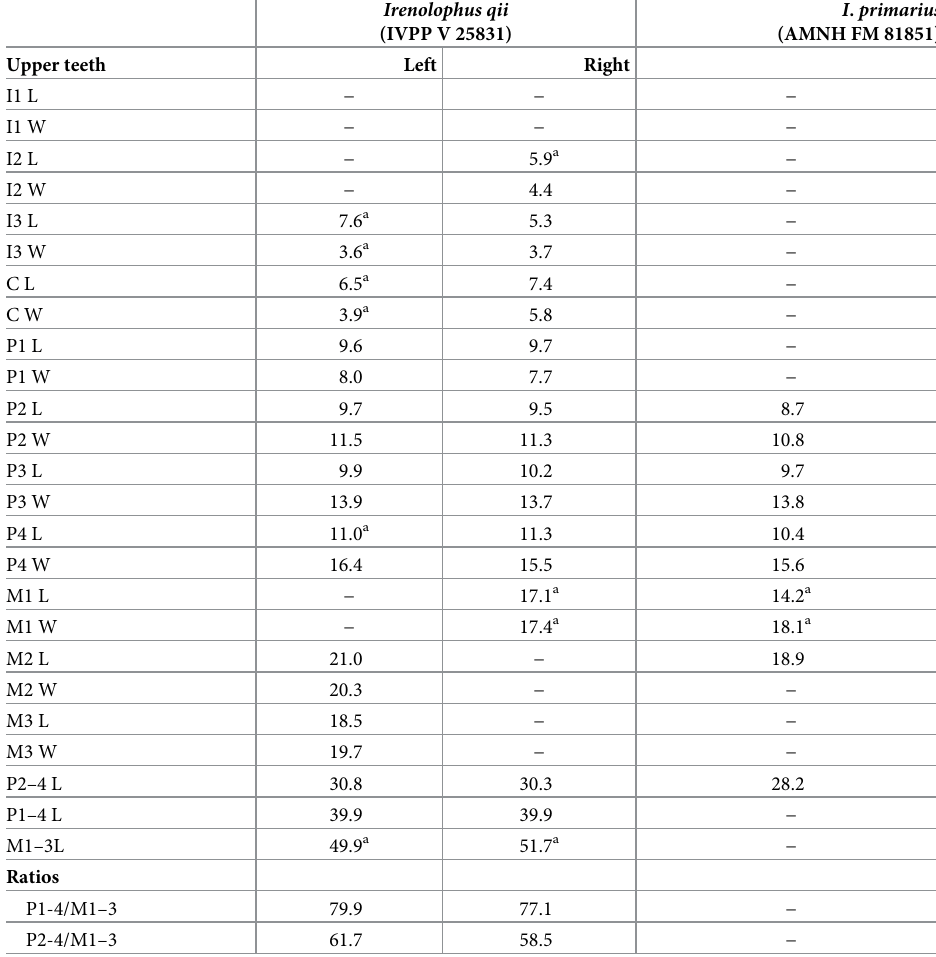
Table 2. Measurements of upper teeth of Irenolophus qii and I . primarius